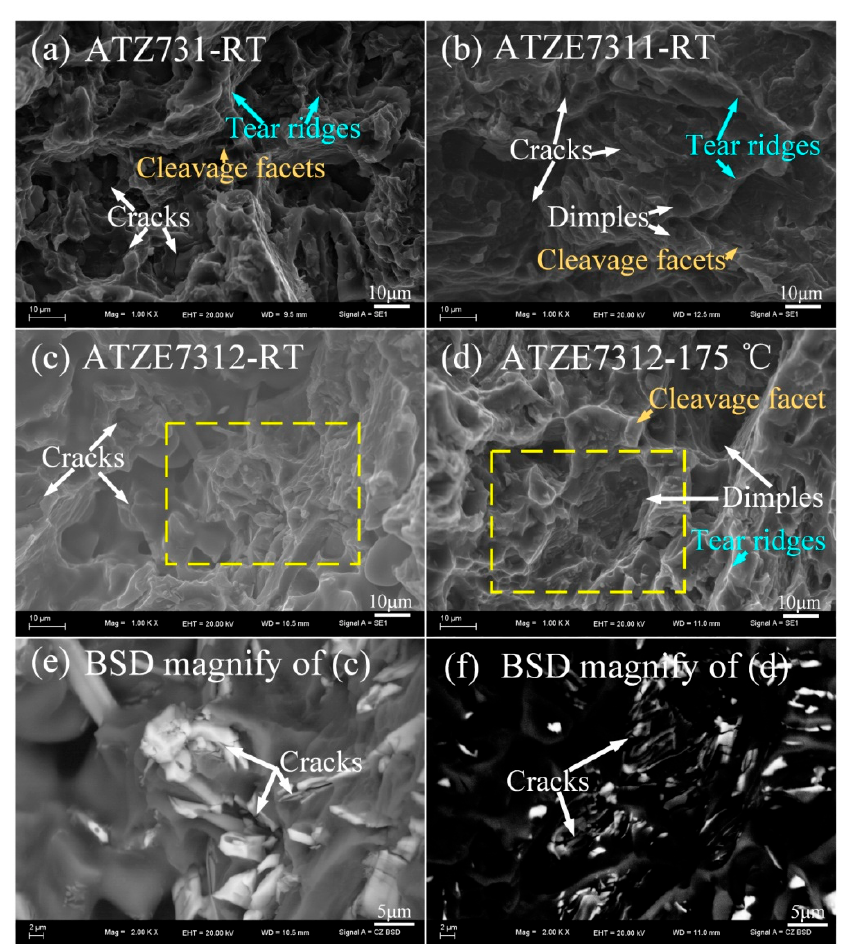
Figure 7. The typical tensile fracture morphologies of as-cast samples tested at RT and 175 °C. ( a ) ATZ731 at RT; ( b ) ATZE7311-RT; ( c ) ATZE7312-RT; ( d ) ATZE7312-175 °C; ( e ) and ( f ) are the high magnify BSD of local ( c ) and ( d ), respectively, as pointed by the dotted-line square.